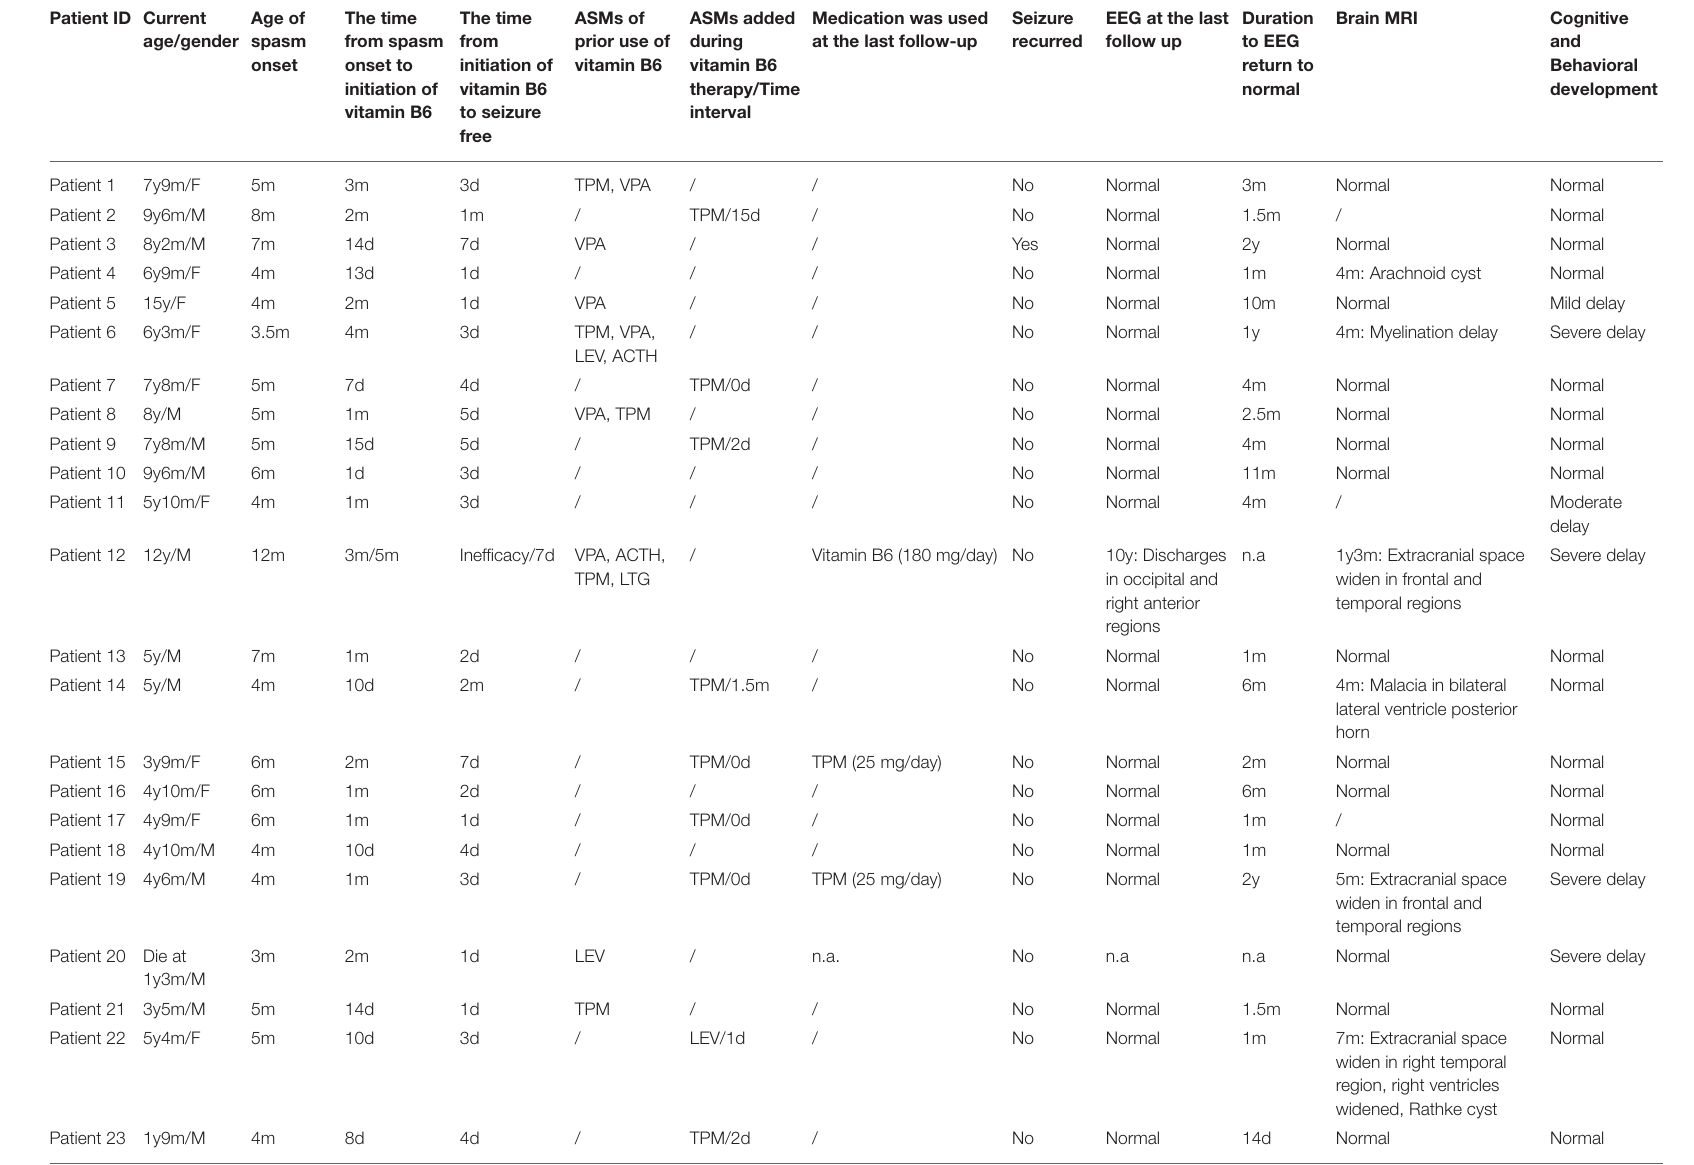
Seizure EEG at the last recurred follow